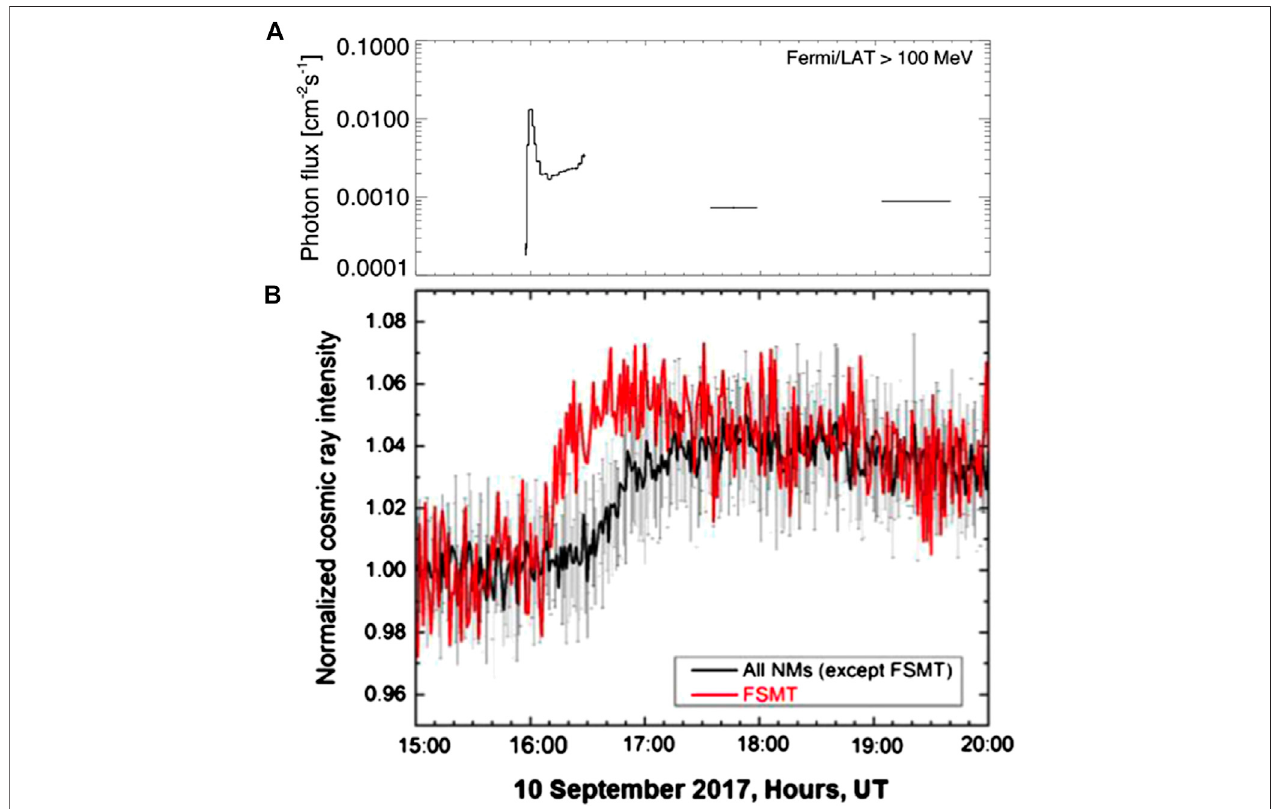
FIGURE6 |(A) Flux of photonsabove 100 MeV (data from Table 1ofOmodei et al. (2018)). (B) Count ratesof neutron monitors at sea level and high geomagnetic latitudeduringthe fi rst4 hofGLE20170910(GLE72).Redcurve:theFortSmith(FSMT)neutronmonitor,whichhastheearliestresponsetosolarparticles.Black:Mean of the other high-latitude monitors. From Kurt et al. (2019). ©Springer Nature. Reproduced with